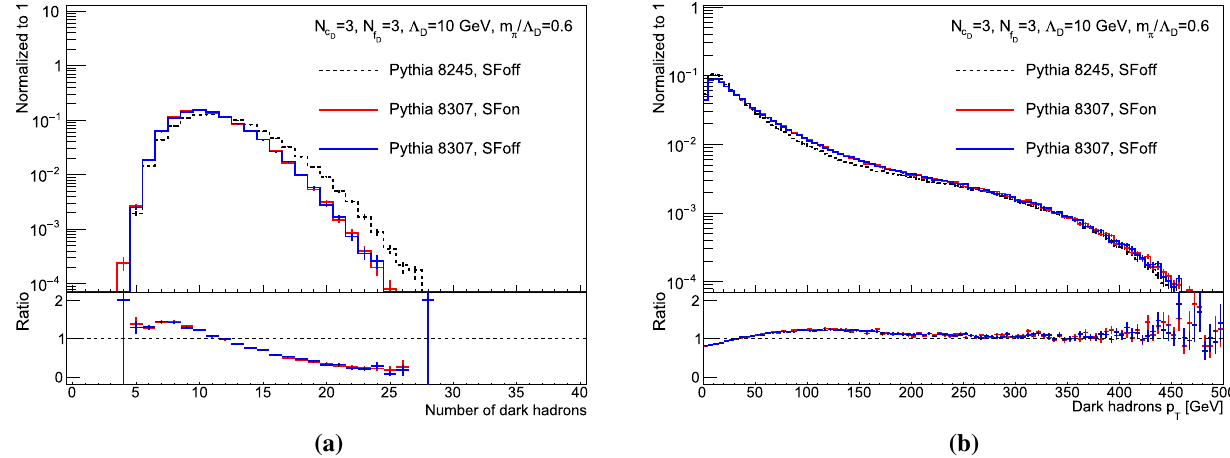
= 3, N = 3 model: a distribution of the number of dark hadrons, b dark hadrons p Fig. 28 N c f D D of the distributions of the new HV module scenarios to the nominal one